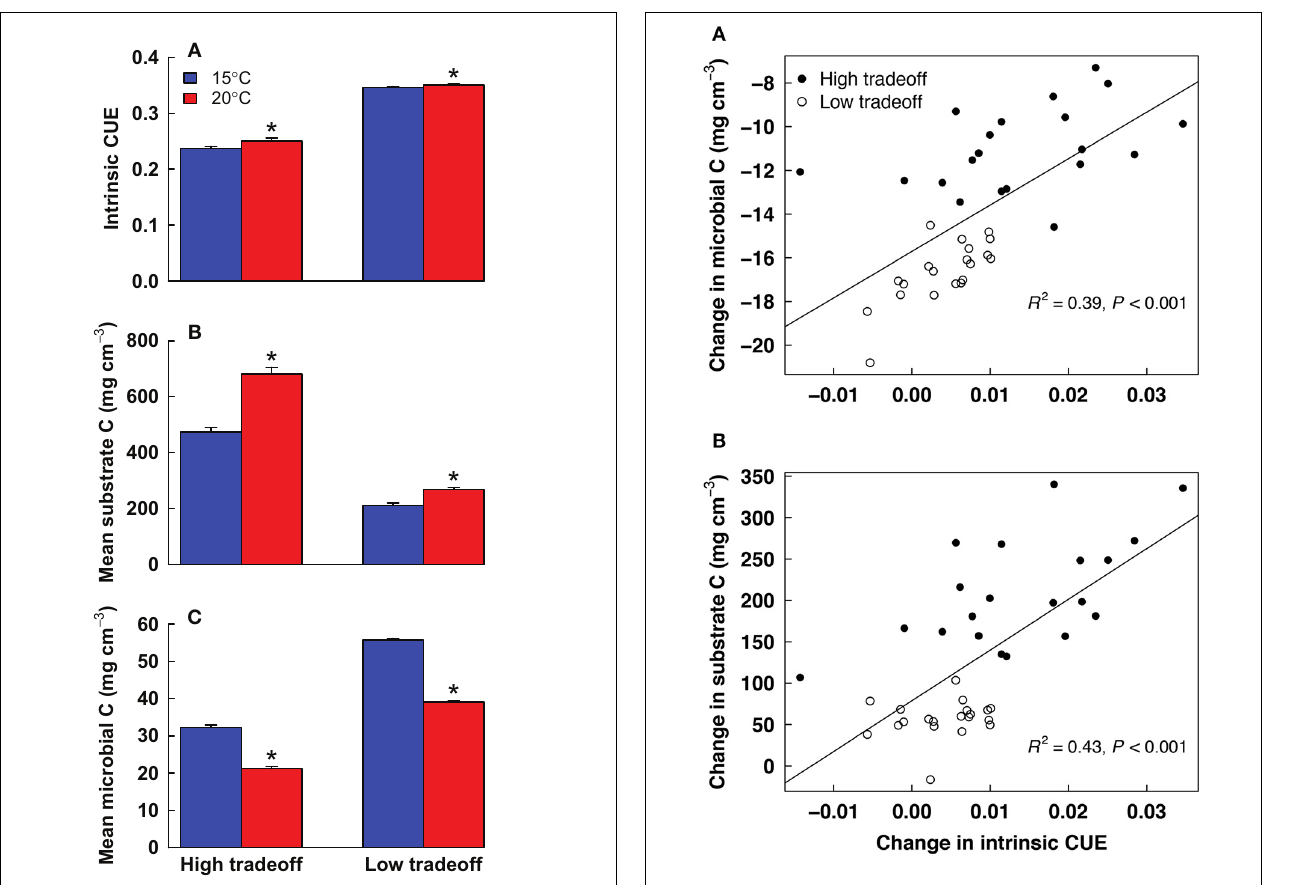
FIGURE 2 | Mean ± SE (A) intrinsic carbon use efficiency (CUE), (B) total substrate carbon, and (C) total microbial biomass carbon under high and low tradeoff scenarios at 15 vs. 20 ◦ C in the DEMENT model. Significant differences between temperatures are noted with an asterisk ( P < 0 . 01, paired t -test).